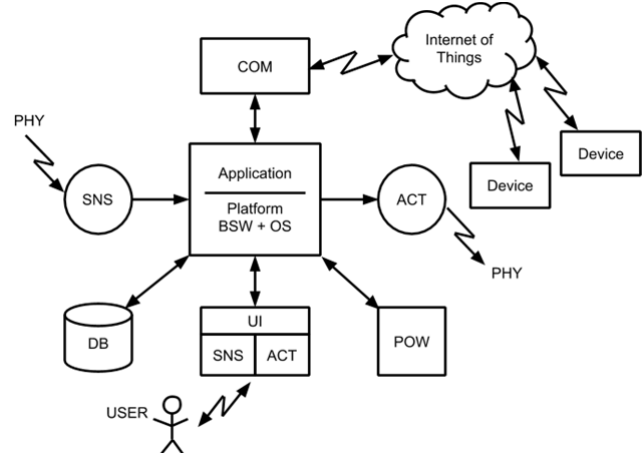
Figure 4. The generic architecture of an IoT